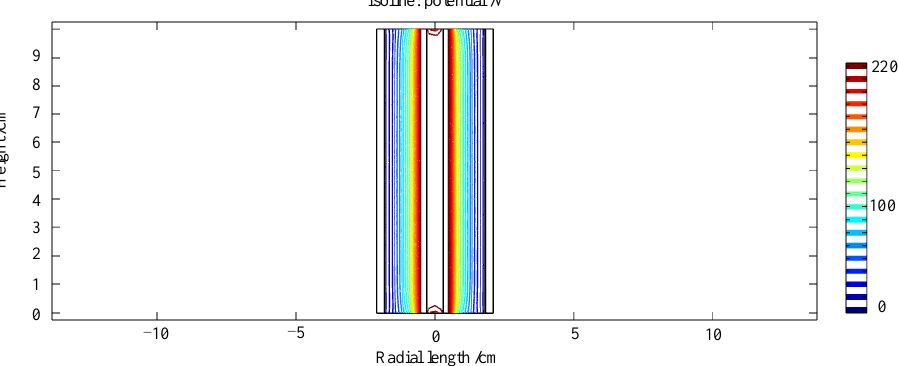
Figure 5. Isogram of electric field distribution in sensor space.